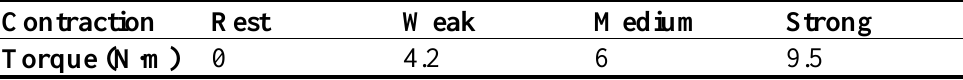
Table 1. Contraction and applied